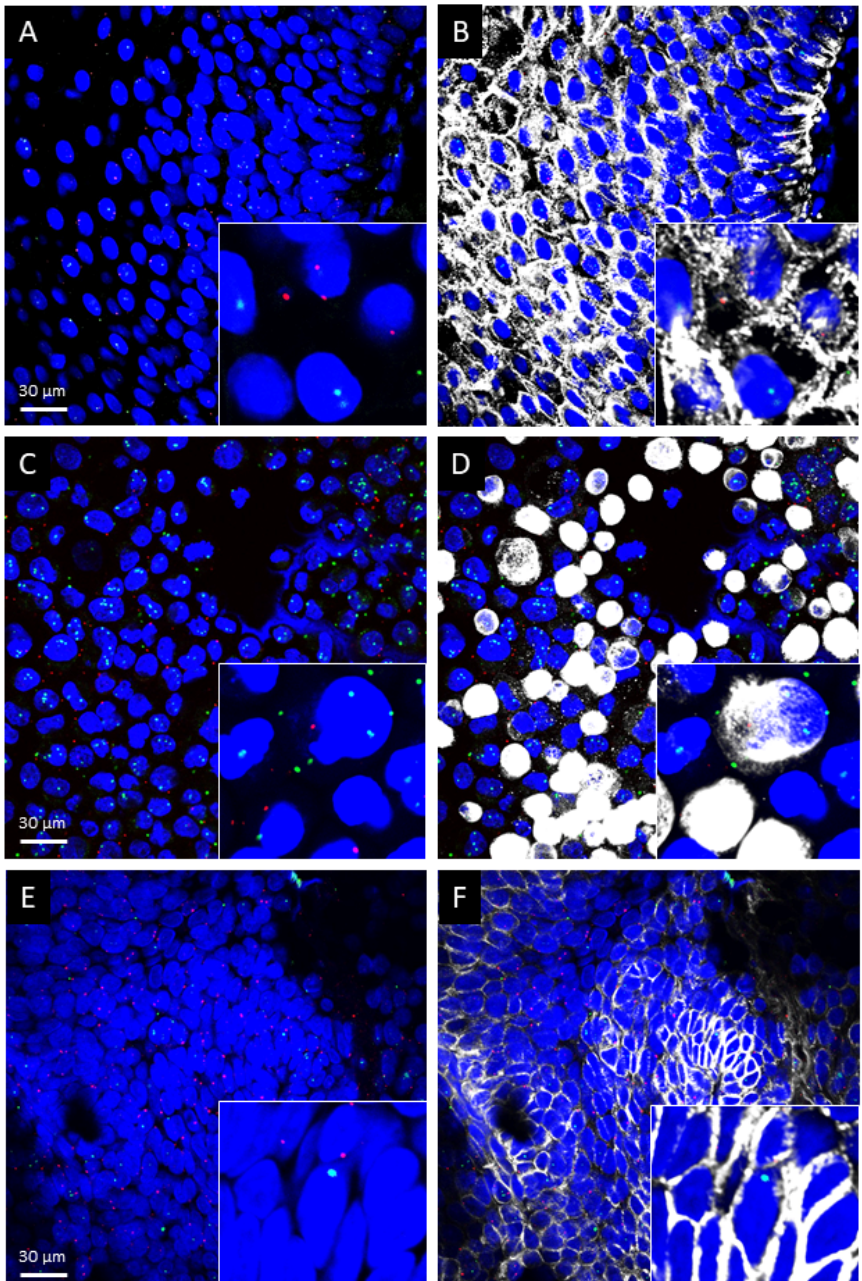
Figure 1. Representative images of Transient Receptor Potential Ankyrin 1 ( TRPA1 ) and Vanilloid 1 ( TRPV1 ) mRNA in normal human oral epithelium ( A , B ), in the PE/CA-PJ41 cell line ( C , D ) and human squamous cell carcinoma ( E , F ). TRPA1 mRNA (red) and TRPV1 mRNA (green) by RNAscope and citokeratin-14 protein (white) by immunofluorescence were depicted and counterstained with DAPI (blue) for nuclei. Scale bar: 30 µm for all images.